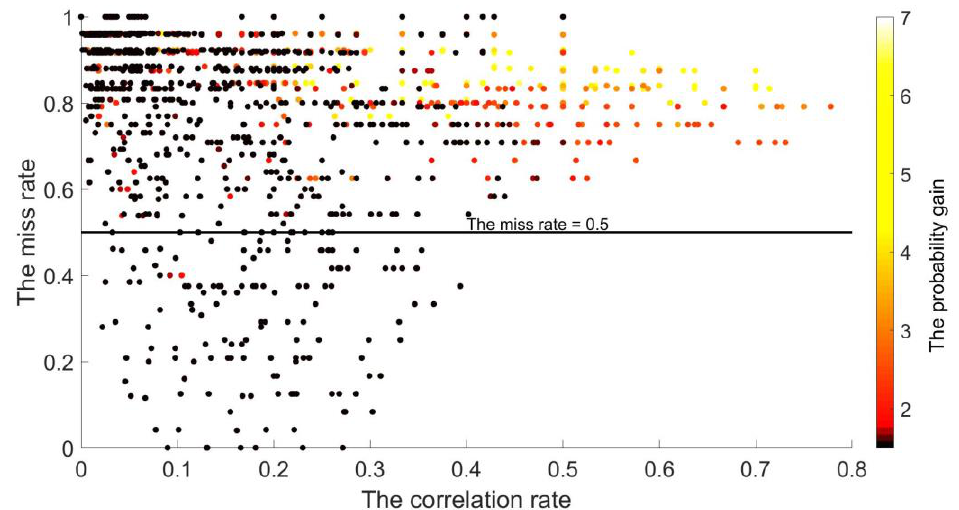
Figure 12. The distribution of the correlation rate, the miss rate and the probability gain. Table 4. The statistical evaluation of the algorithm with different